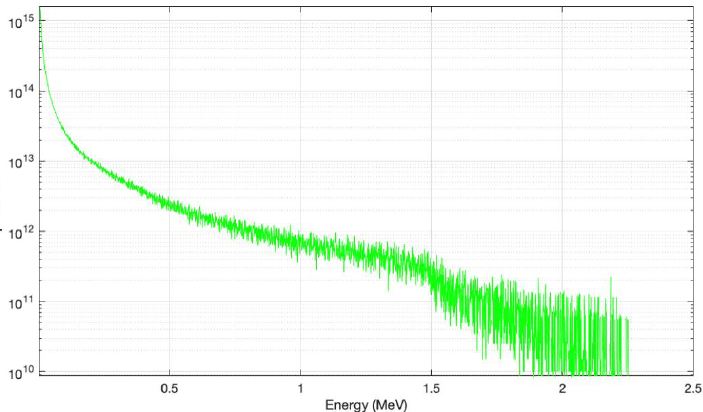
Figure 8. Spectrum of proton energy acceleration obtained from 2D PIC simulation with the density trap and foil at t = 1000 fs and efficiency of 55%. In contrast the foil only case results with maximum proton energy of 0.05 MeV and efficiency of